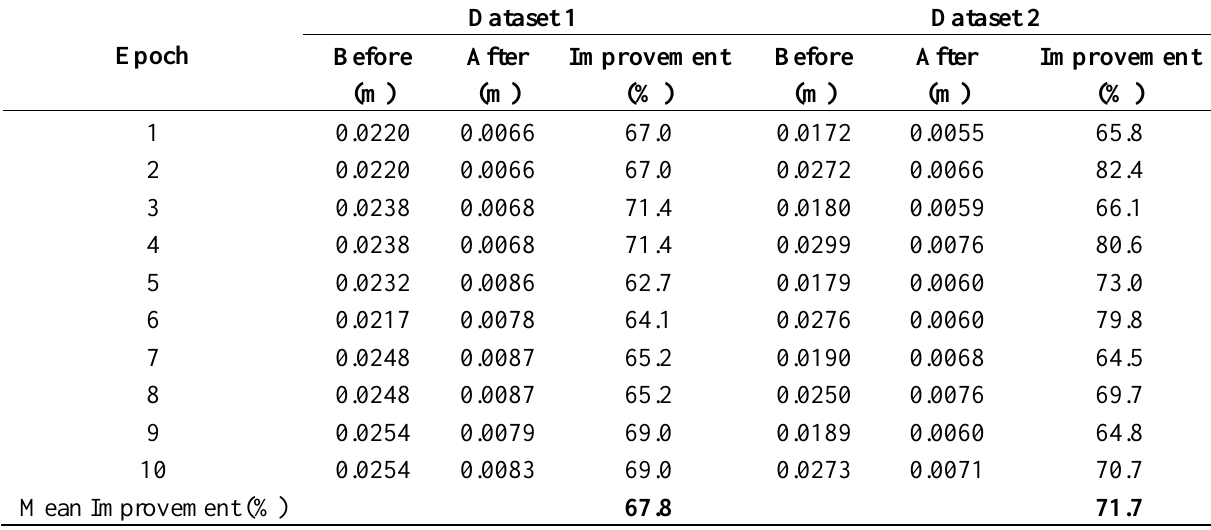
Table 1. RMS of the check plane fitting misclosures for an individual laser in static